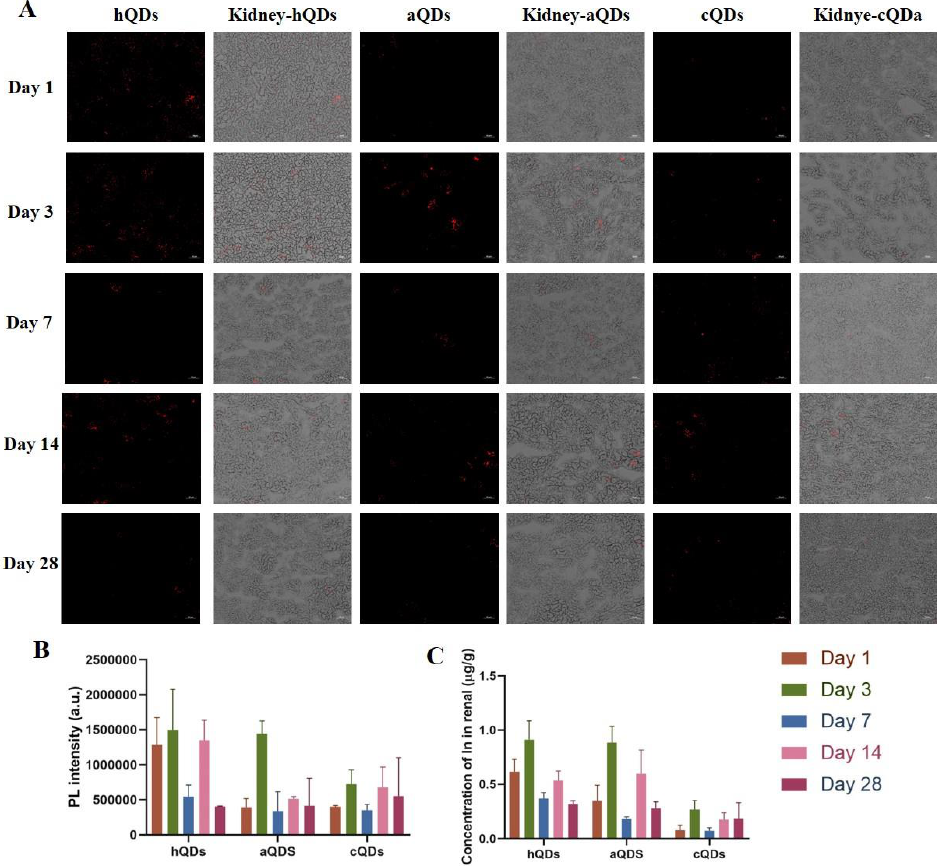
Figure 3. Distribution of QDs in kidney. ( A ) Representative fluorescence images of kidney tissue of mice administered with 25 mg/kg BW QDs at different predetermined time points (the red signal represented the fluorescence of QDs, scale bar: 50 µ m). ( B ) Time-course of integrated mean PL intensity of QDs in renal tissue. ( C ) The In element concentration in kidney after administration of the three QDs at 25 mg / kg